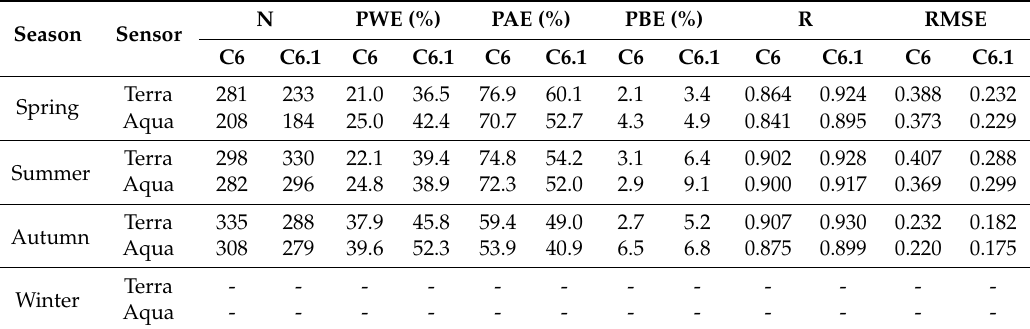
Figure 9. Validation of the MODIS-Terra (MOD04) C6 DT ( a ) and MOD04 C6.1 DT ( b ) AODs for the years, 2001–2016, and the MODIS-Aqua (MYD04) C6 DT ( c ) and MYD04 C6.1 DT ( d ) AODs for the years, 2002–2016, against the AERONET AODs. The red line is the regression line, the black solid line is the 1:1 line, and the black dashed lines indicate the envelope of the expected error (EE). Table 1. Comparison of the retrieval accuracy between the MOD04/MYD04 C6 DT and C6.1 DT AOD products in the four